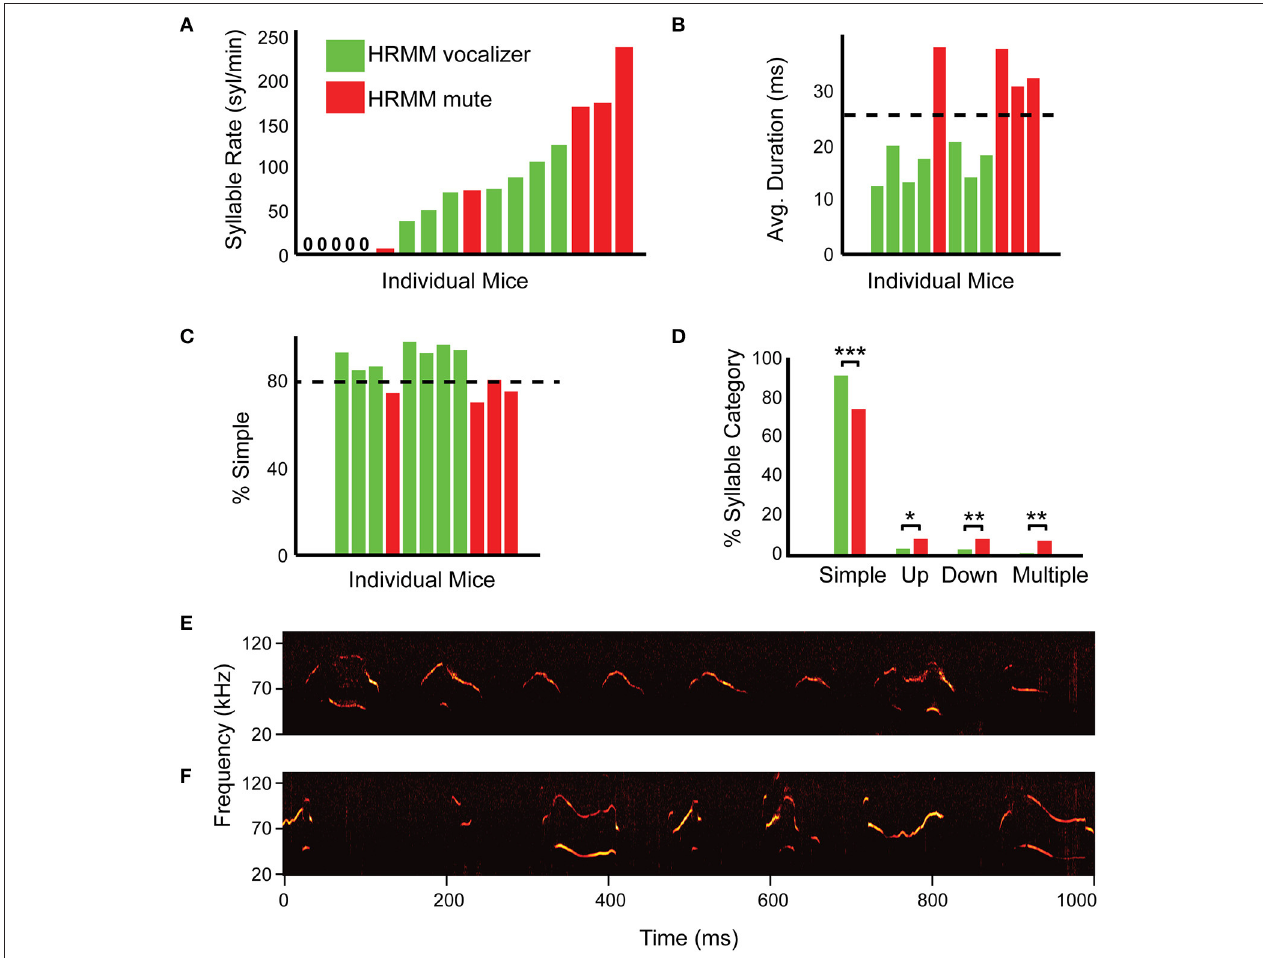
FIGURE 3 | Simple percentage and average syllable duration successfully predict head-fixed vocalizers. (A) Quantification of syllable rate for individual mice in the first session (S1—non-restrained male and female) colored by their performance on session 4 (head restrained). Green marks mice that vocalized when head restrained and red marks mice that were mute when head-fixed. Note that some mice vocalized at high rate in session 1 but nevertheless after habituation were mute when head-restrained. This indicates that syllable rate alone is insufficient as a predictor for head-restrained vocalizations. (B) Average USV durations sorted by syllable rate for each individual head-restrained vocalizing mouse in session 1 with 11/17 total mice represented (color code as in (A) with head-restrained mute mice omitted). Head-restrained vocalizers made shorter duration syllables on average as compared to head-restrained mute mice ( p = 0.0001). (C) Percentage of “simple” syllables for each individual head-restrained vocalizing mouse during session 1 sorted by syllable rate (same color code as in B ). (D) Comparisons of syllable percentage across syllable category for HRMM—vocalizers and mute. “Simple” syllables ( p = 0.0002) can assist in predicting which mouse can be habituated to vocalize while head-fixed. (E) A representative example of a spectrogram from HRMM vocalizer in first session (S1, while non-restrained) with few “non-simple” vocalizations. (F) A representative example of a spectrogram from first session mute HRMM with many “non-simple” vocalizations. * p < 0.05, ** p < 0.01, and *** p <